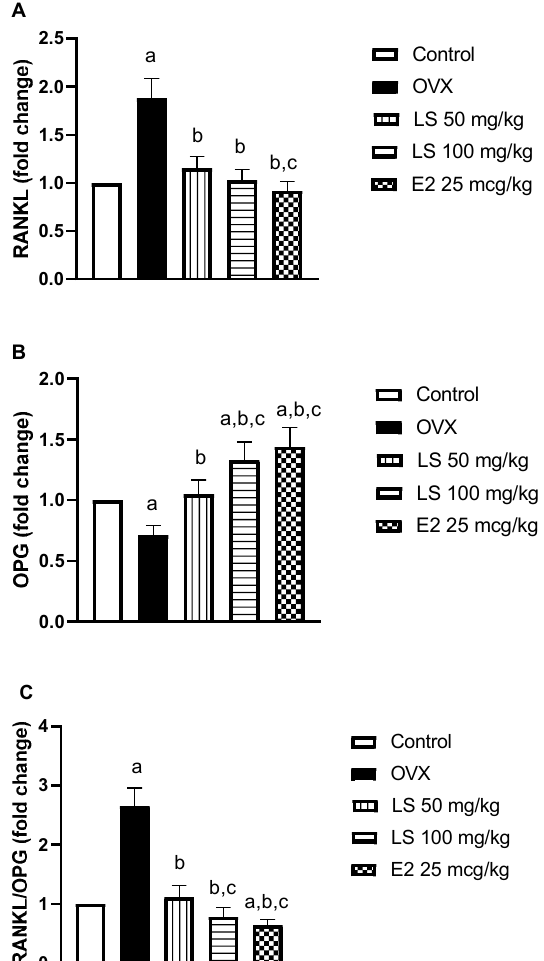
Figure 4. E ff ect of L. sativum (LS) on mRNA expression of receptor activator of nuclear factor kappa-B ligand ( RANKL ) and osteoprotegerin ( OPG ) and RANKL / OPG ratio in femur bones of ovariectomized rats. ( A ) The levels of RANKL mRNA transcripts; ( B ) the levels of OPG mRNA transcripts; ( C ) RANKL / OPG ratio. Data are expressed as means ± SD. (a) Significantly di ff erent from control at p < 0.05. (b) Significantly di ff erent from OVX at p < 0.05. (c) Significantly di ff erent from LS 50 mg / kg at p < 0.05.